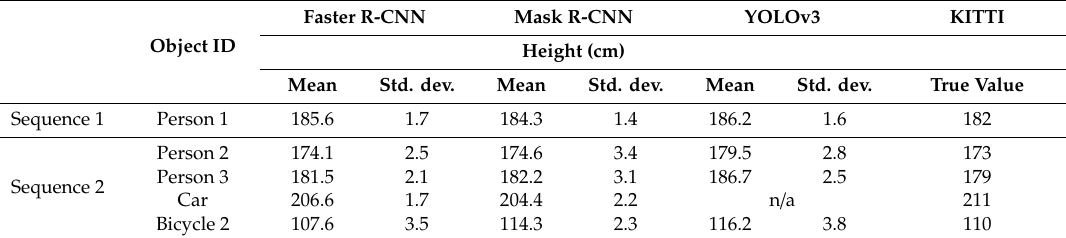
Figure 14. Results of object detection applying various models to KITTI dataset. Table 5. Evaluation of geometric measurement applying various models to KITTI dataset.